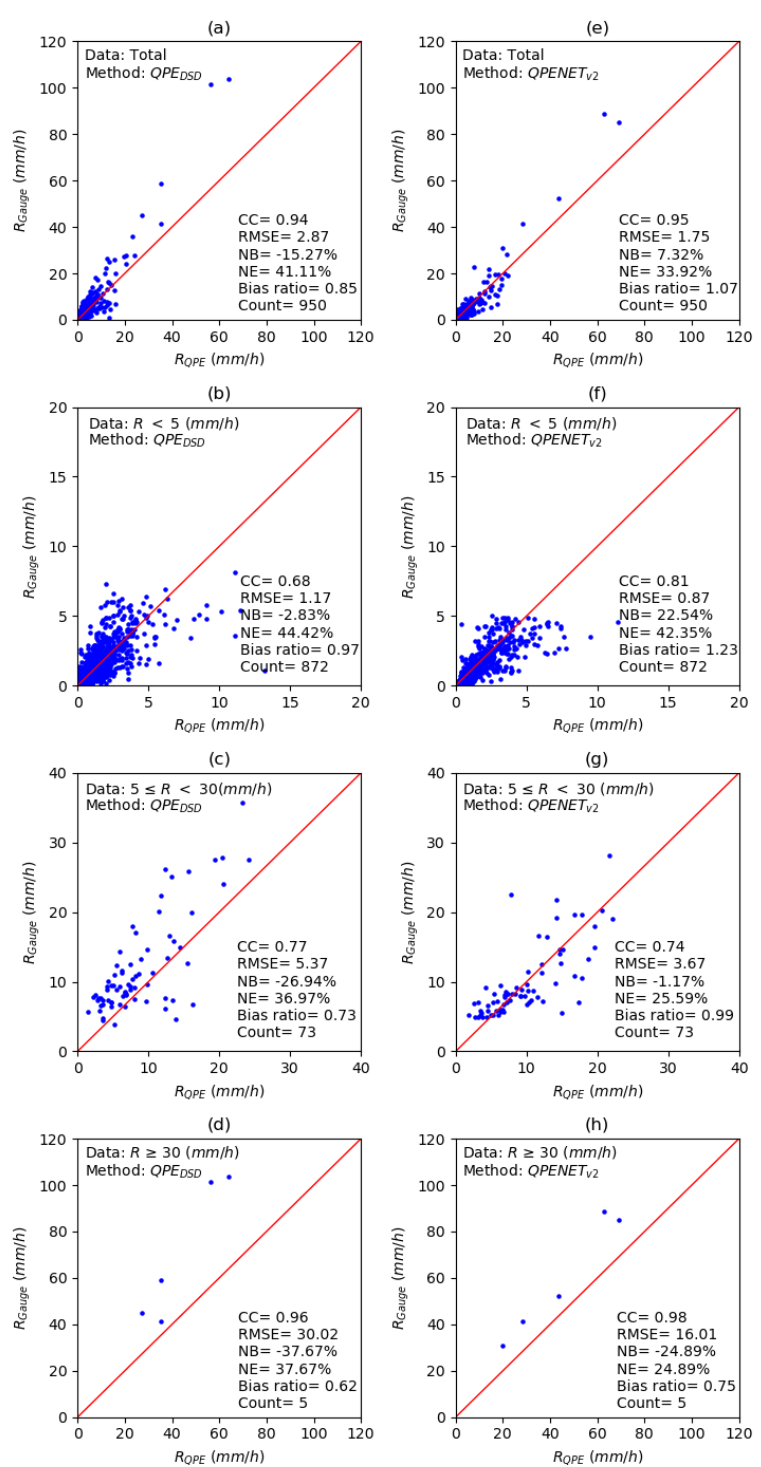
Figure 8. Scatterplots of rainfall estimates from the automatic weather stations versus radar during typhoon Merbok. ( a – d ) QPE DSD . ( e – h ) QPENet V2 . ( a , e ), ( b , f ), ( c , g ), and ( d , h ) correspond to all rainfall intensities, R < 5 mm · h − 1 , 5 ≤ R < 30 mm · h − 1 , and 30 mm · h − 1 ≤ R , respectively. 5.2. Performance of QPE DSD and QPENet V2 on Different Segments of Z H , Z DR , and K DP The bias ratio and RMSE of the derived rainfall estimates using the QPE DSD and QPENet V2 algorithms were compared for different segments of Z H and Z DR (Figure 9). When Z H was small (<20 dBZ), the bias ratios of the two algorithms first increased